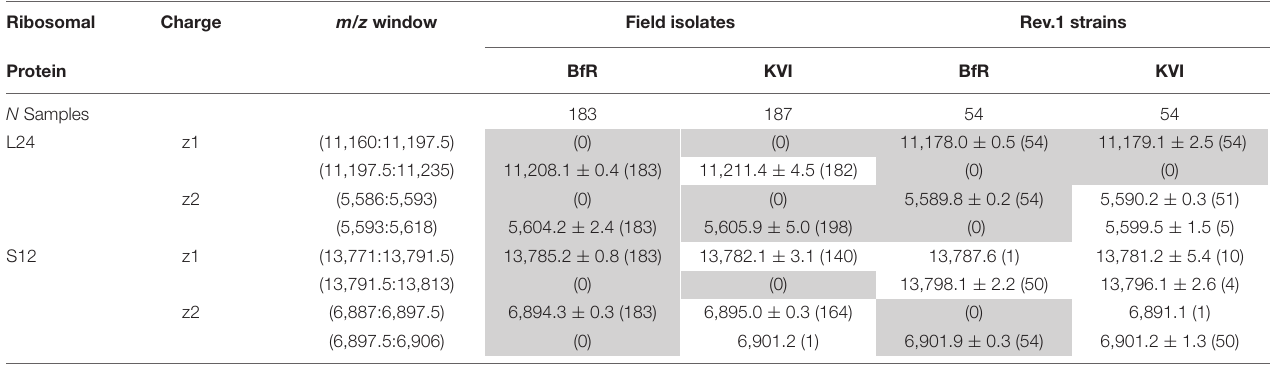
TABLE 2 | Statistics of strain discrimination by mass and intensity decision boundaries. Ribosomal Charge m/z window Field isolates Rev.1 strains